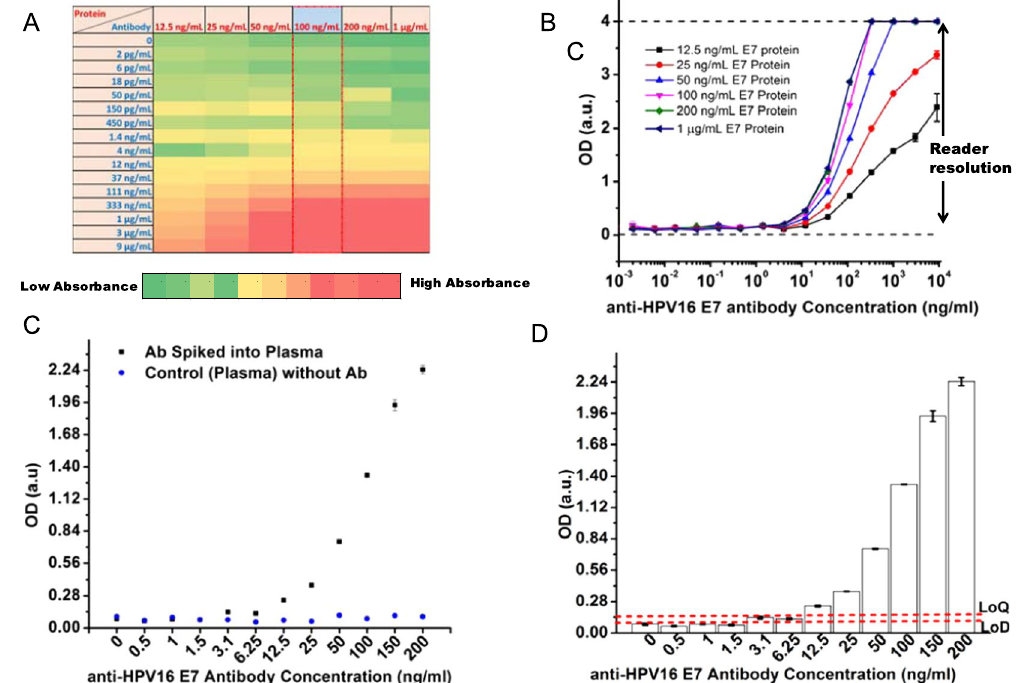
Figure 3. Developing the customized immunoassay by spiking anti-HPV16 E7 antibody into plasma and use various protein concentration. ( A ) In the experiments, we initially coated the wells surfaces with various concentrations of HPV16 E7 protein ranging from 12.5 ng/mL to 1 μ g/mL. We then applied different concentrations of anti-HPV16 E7 antibody between 2 pg/mL and 9 μ g/mL to these wells, followed by the color development using HRP-conjugated secondary antibody (80 ng/mL). The absorbance value at 450 nm was used as the signal unit of customized immunoassay. ( B ) As a result, we observed no differences in the OD values above 100 ng/mL of HPV16 E7 protein, which implied a saturation level for the protein. At the protein concentrations between 12.5 ng/mL and 100 ng/mL, we observed distinguishable OD levels. As manufacturer reported, the maximum resolution limit in absorbance (OD) of the plate reader is 4 a.u. Limit of detection (LoD) and limit of quantitation (LoQ) parameters of the customized immunoassay. In the experiments, we first spiked different concentrations of anti-HPV16 E7 antibody ranging from 1 ng/mL to 200 ng/mL into plasma. In this step, plasma samples were obtained using a centrifugation method. Negative control was defined as plasma sample without anti-HPV16 E7 antibody. Here, LoD and LoQ were used to evaluate immunoassay performance. ( C ) Experimental LoD was obtained using a statistical assessment by comparing OD values in plasma spiked samples and negative control. As a result, 3.1 ng/mL of anti-HPV16 E7 antibody concentration provided statistically different OD value compared to the negative control. ( D ) Theoretical LoD was calculated using Eq. 2. 2.87 ng/mL of anti-HPV16 E7 antibody concentration was calculated as theoretical LoD value and 6.5 ng/mL was calculated as LoQ value using Eq. 3. Statistical analyses were performed using one way analysis of variance (ANOVA), followed by Tukey’s post hoc analysis (n = 3, p <